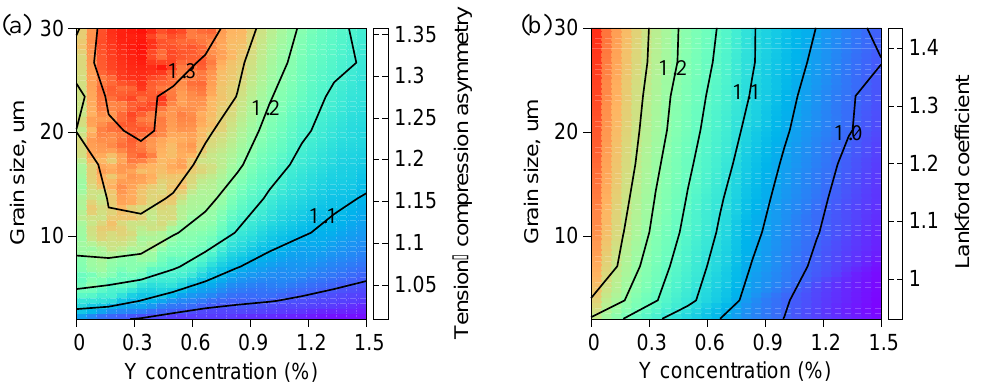
Figure 8. Effect of grain size and Y content on ( a ) tension–compression asymmetry and ( b ) Lankford coefficient for transverse direction (TD) loading in Mg-Y alloys.